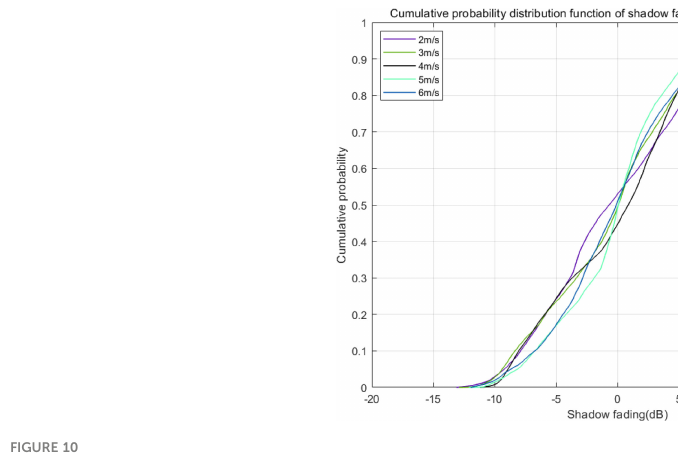
FIGURE 10 CDF of the shadow fading for Area 1.